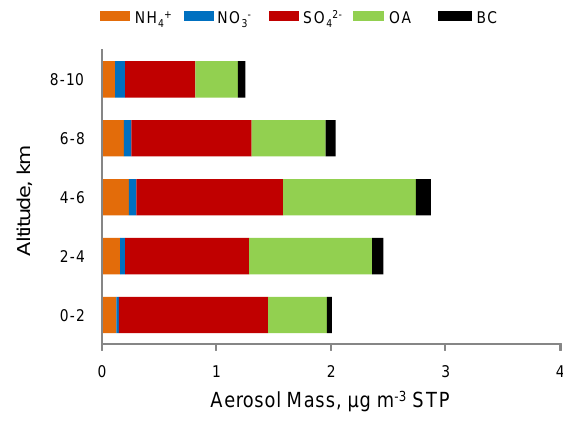
Fig. 5. Fine aerosol composition observed along the ARCTAS DC- 8 flight tracks (1–19 April 2008), averaged over 2-km altitude bins. The averaging excludes data collected south of 60 ◦ N, in strato- spheric air, and in biomass burning plumes (see